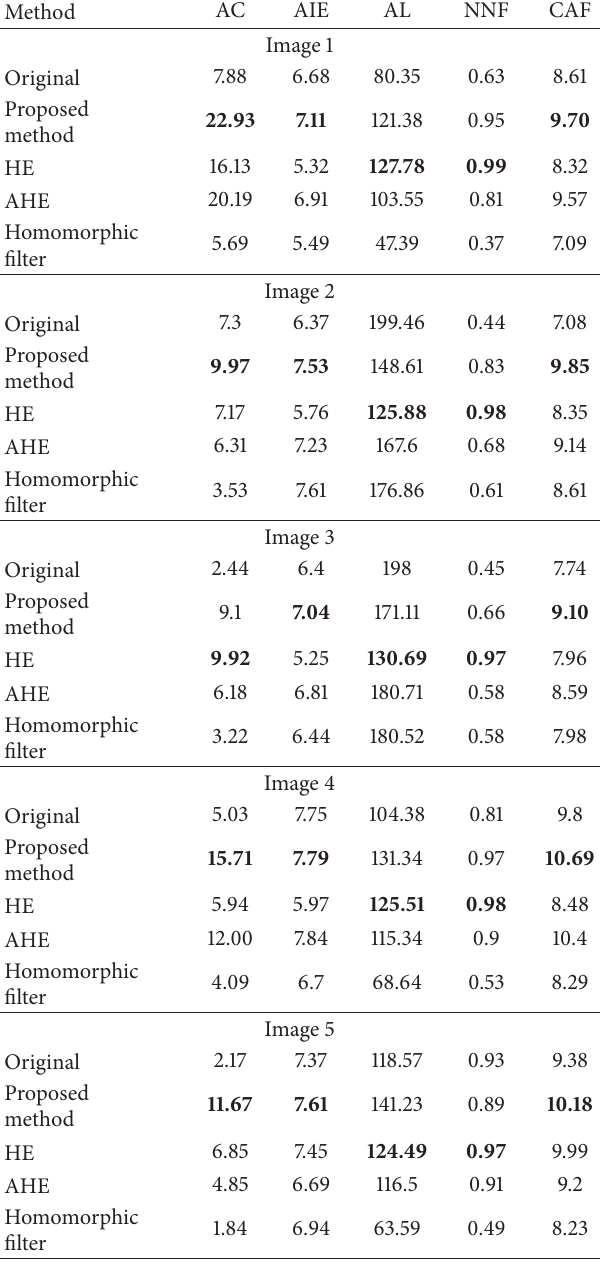
Table 1: Comparison of